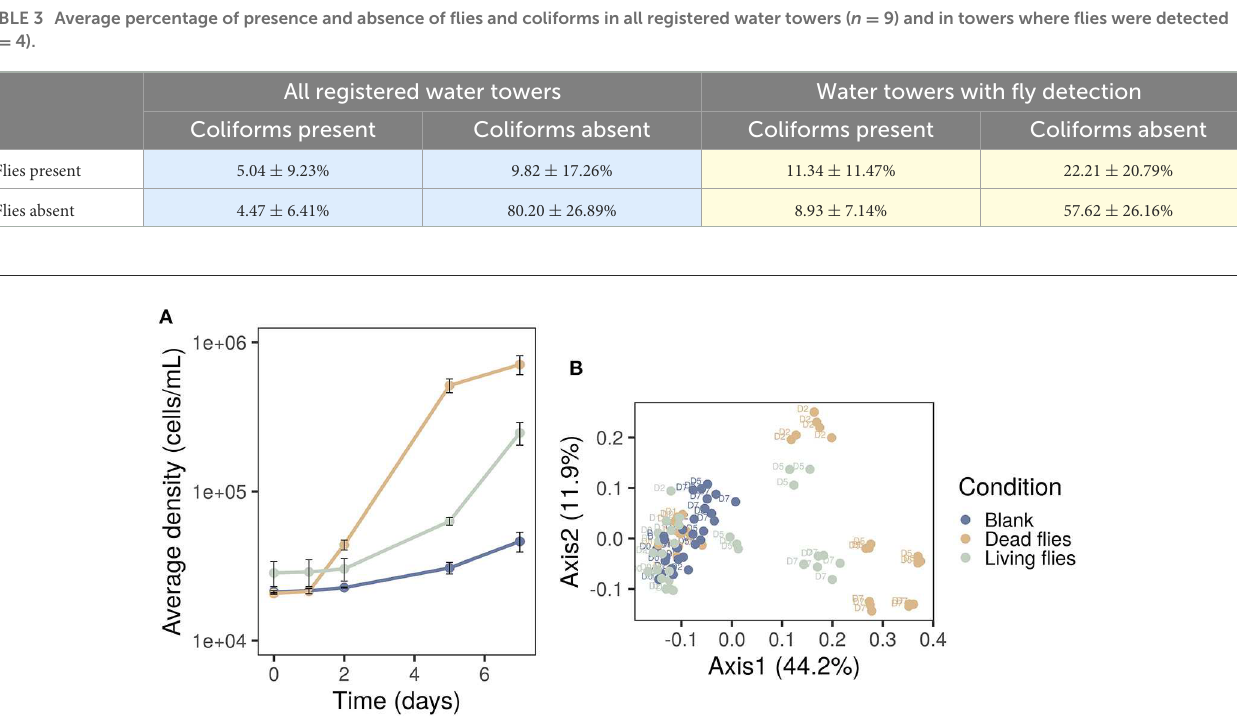
FIGURE4 (A) Cell concentrations and (B) PCoA diversity analysis of samples with flies (living, dead) and without flies (blank) acquired with flow cytometry. Both biological ( n = 2) and technical ( n = 3) were considered. The addition of flies leaded to increased cell densities and phenotypic changes of the indigenous drinking water